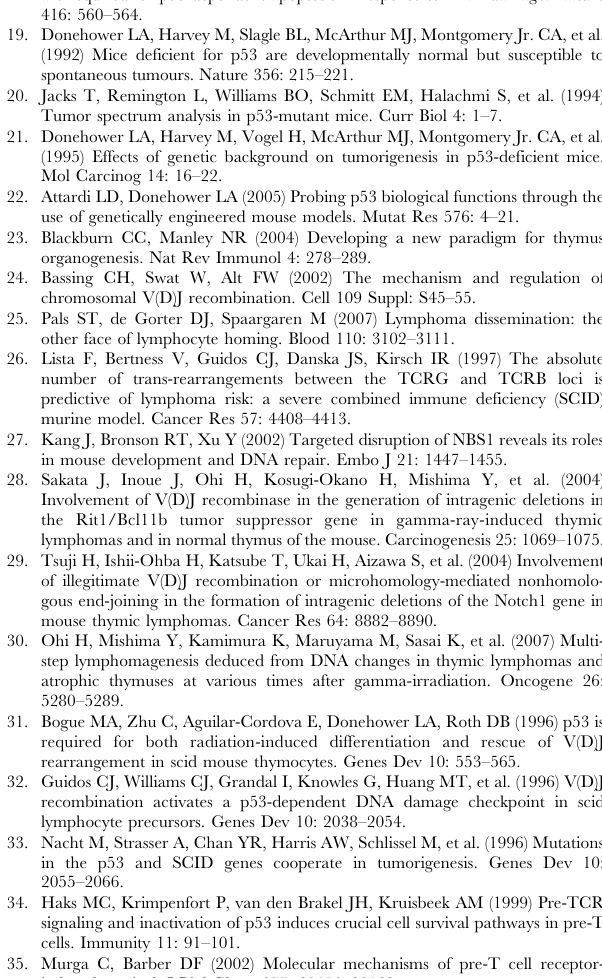
Figure S3 CGH analysis of chromosomal alterations in primary T cell lymphomas from p53 2 / 2 , p53-p73 + / 2 and p53 2 / 2 p73 2 / 2 mice. The results are representative of five tumors of each genotype. Chromosomal gains are shown in green, while